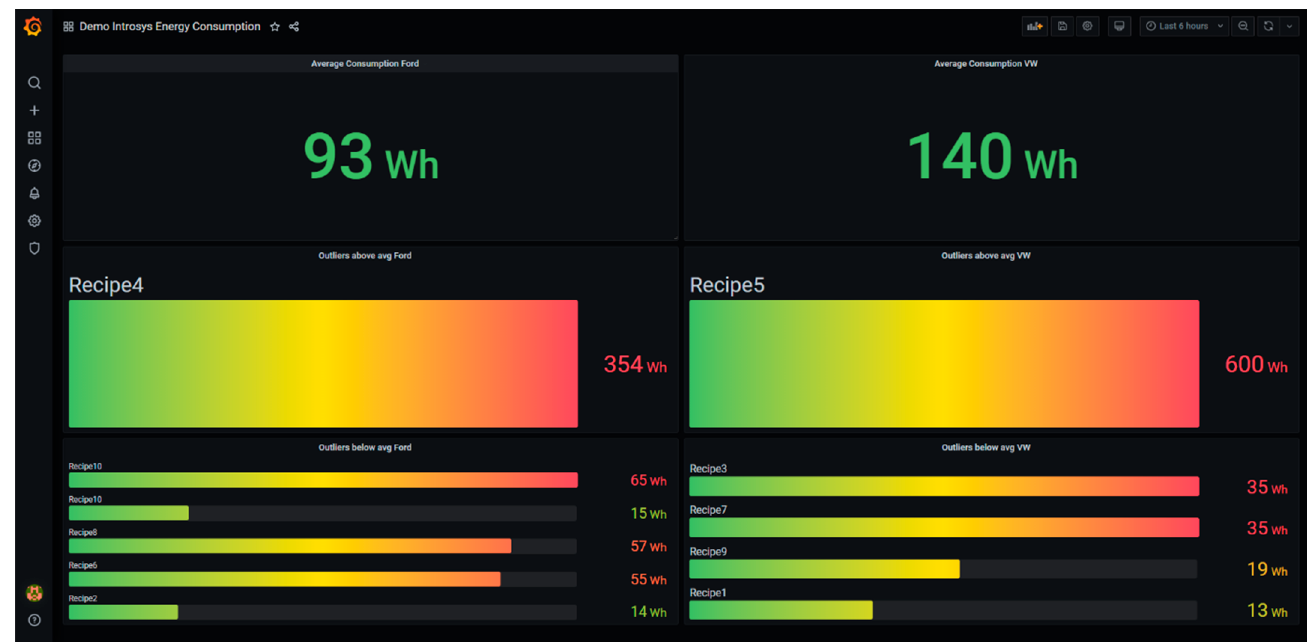
Figure 14. Energy Consumption Human Machine Interface.